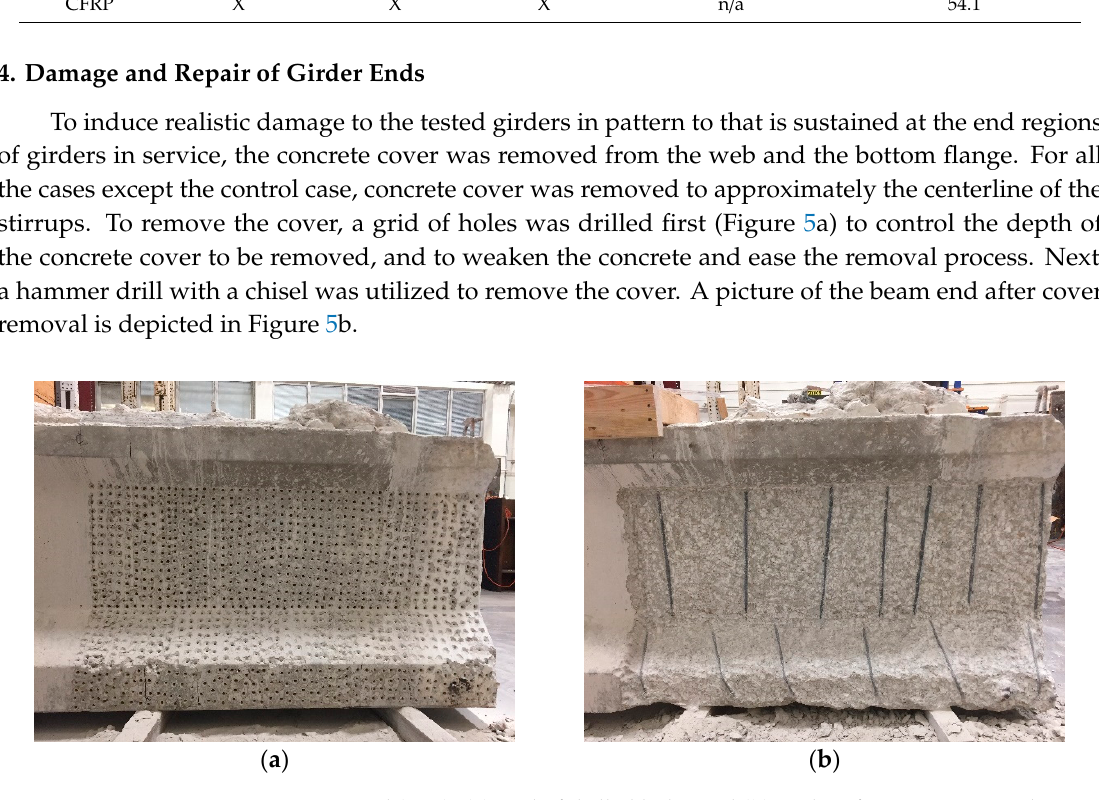
Figure 5. Concrete cover removal (1:27): ( a ) grid of drilled holes and ( b ) girder after cover removal.